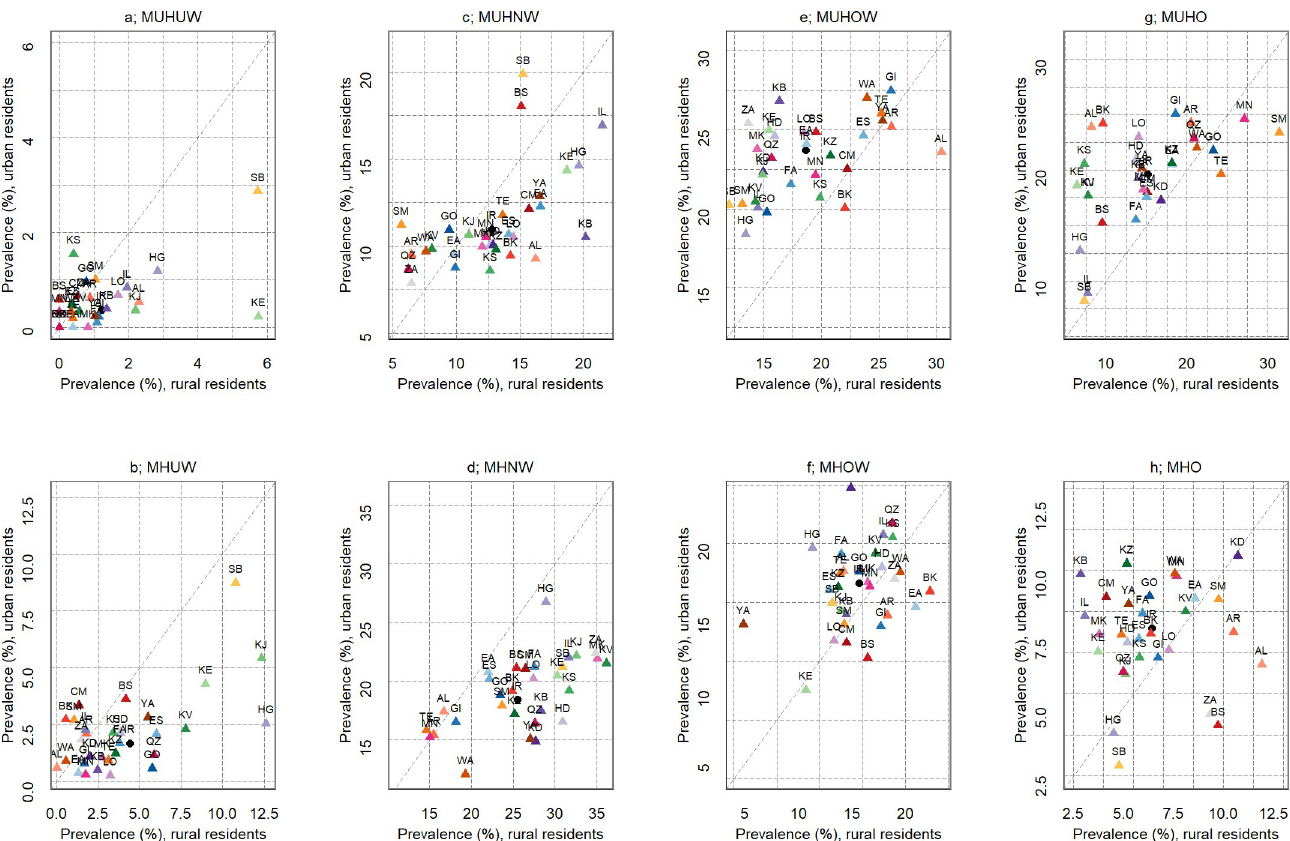
Fig 4. Sub-national prevalence of metabolic phenotypes for each BMI category by area of residence. (a) MUHUW: metabolically unhealthy underweight, (b) MHUW: metabolically healthy underweight, (c) MUHNW: metabolically unhealthy normal weight, (d) MHNW: metabolically healthy normal weight, (e) MUHOW: metabolically unhealthy overweight, (f) MHOW: metabolically healthy overweight, (g) MUHO: metabolically unhealthy obese, (h) MHO: metabolically healthy obese.